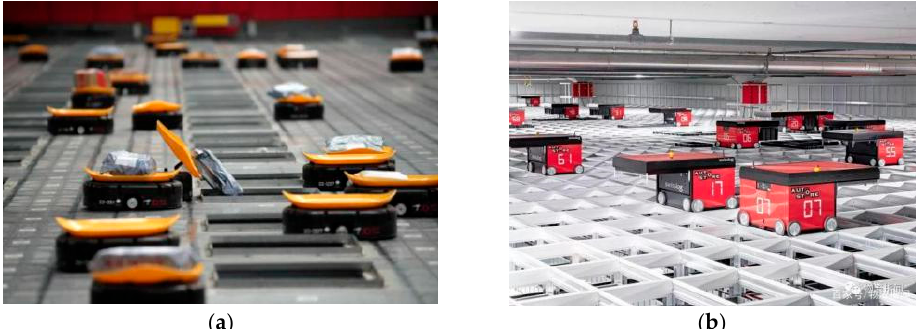
Figure 1. Grid map workspace application scenarios: ( a ) a sorting robot system, cited in web (http://www.sd.chinanews.com/2/2018/0606/59838.html), ( b ) an autonomous warehouse, cited on the web (https://baijiahao.baidu.com/s?id=1637276211094569677&wfr=spider&for=pc).